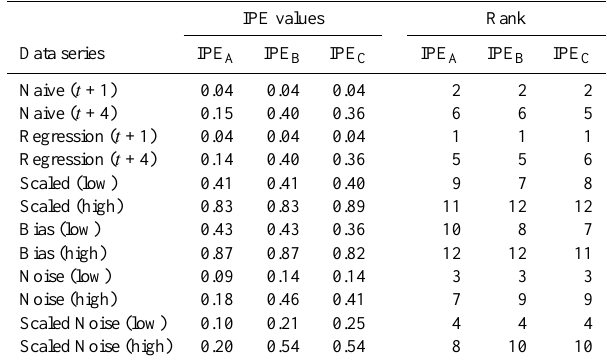
Table 4. Integrated assessment of experimental data